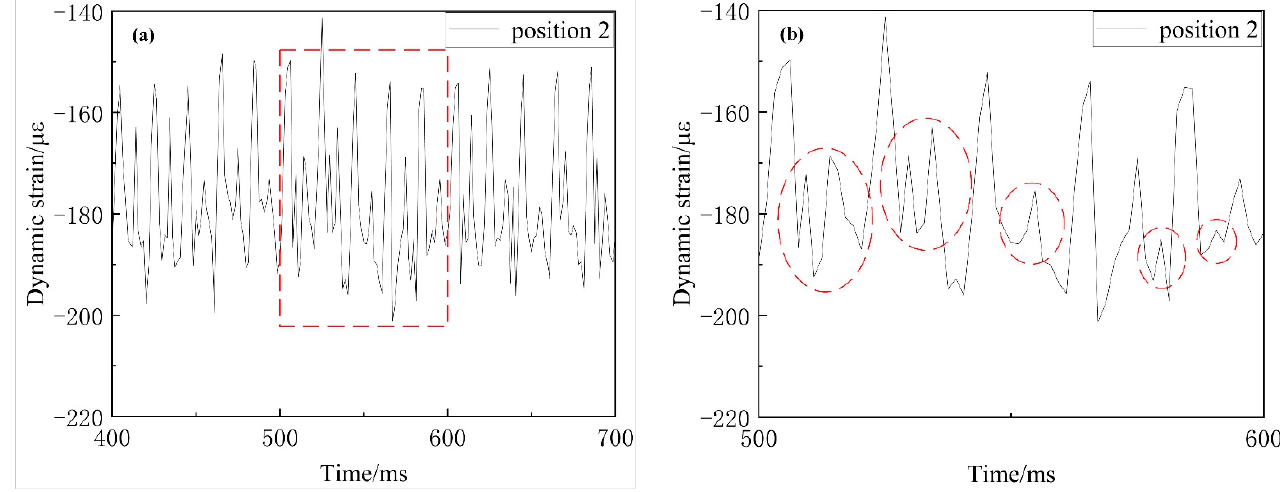
Figure 10. Dynamic strain curve at the back of Grade A marine steel specimens: ( a ) dynamic strain obtained by strain gauge 2 under 200 MPa jet erosion; ( b ) local magnified view of dynamic strain obtained by strain gauge 2 under 200 MPa jet erosion.